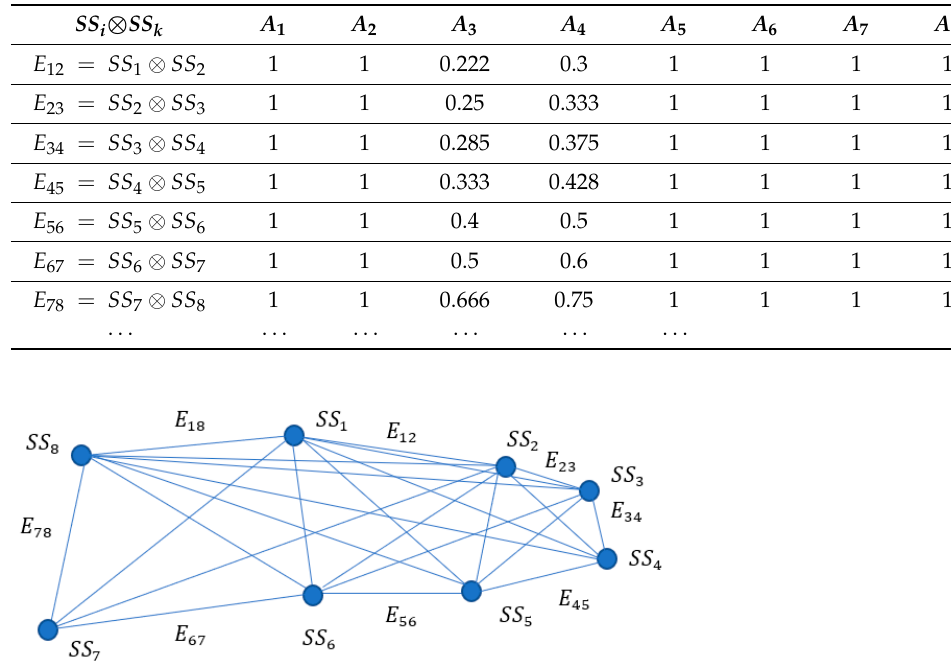
Figure 10. M-polar fuzzy graph at design of subtracting amplifier.